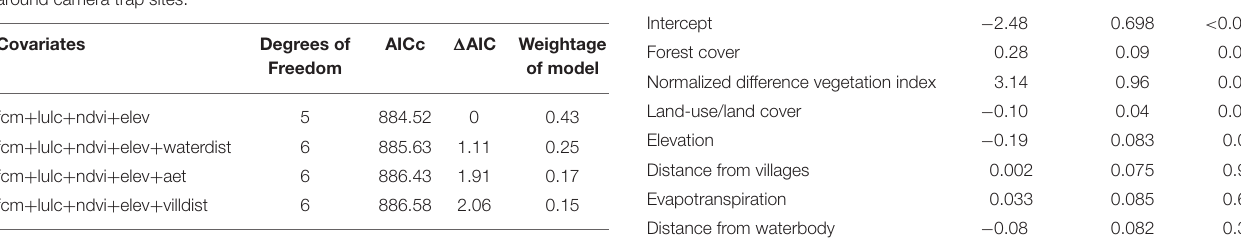
elev, elevation; aet, actual evapotranspiration; lulc, Landuse/landcover; fcm, forest cover; ndvi, normalized difference vegetation Index; waterdist, distance from water; villdist, distance from villages.